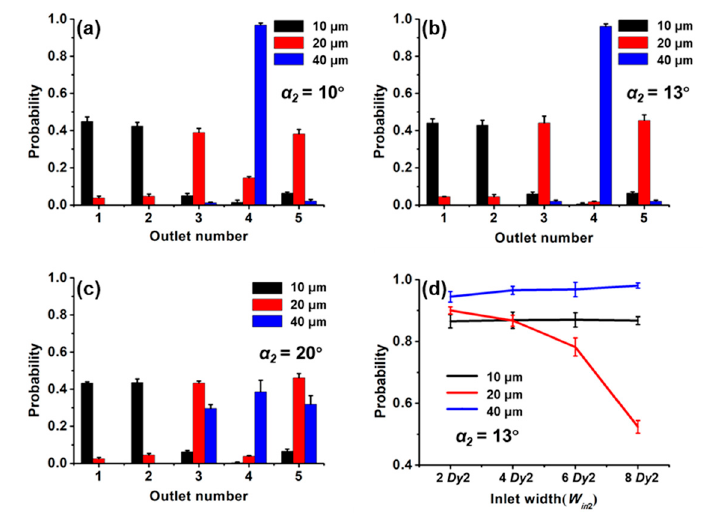
Figure 6. Probability distributions of the magnetic beads at all outlets with the forcing angles of ( a ) 10°, ( b ) 13° and ( c ) 20° when the W in 2 = 2 Dy 2. ( d ) Probability distribution of magnetic beads for different W in 2 at α 2 = 13°.